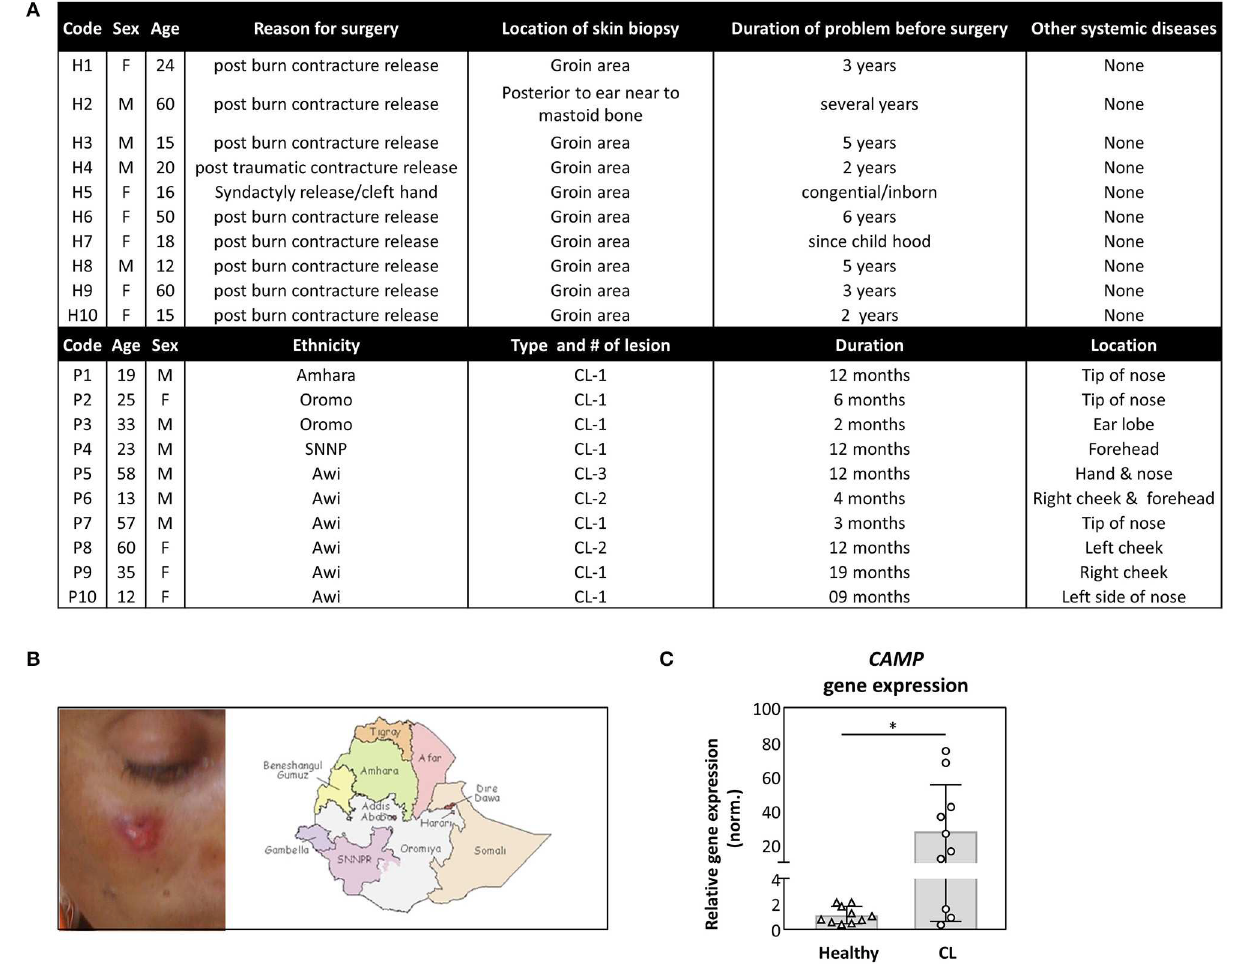
( Figure 3F ). Of note, the transgenic Lm promastigotes transformed into amastigotes in vitro , as the expression of dsRed increased (increase in mean fluorescent intensity, MFI) ( Figure 3G ). Altogether, pro-inflammatory human macrophages were demonstrated to express cathelicidin to a higher extent, which may contribute to an impaired parasite